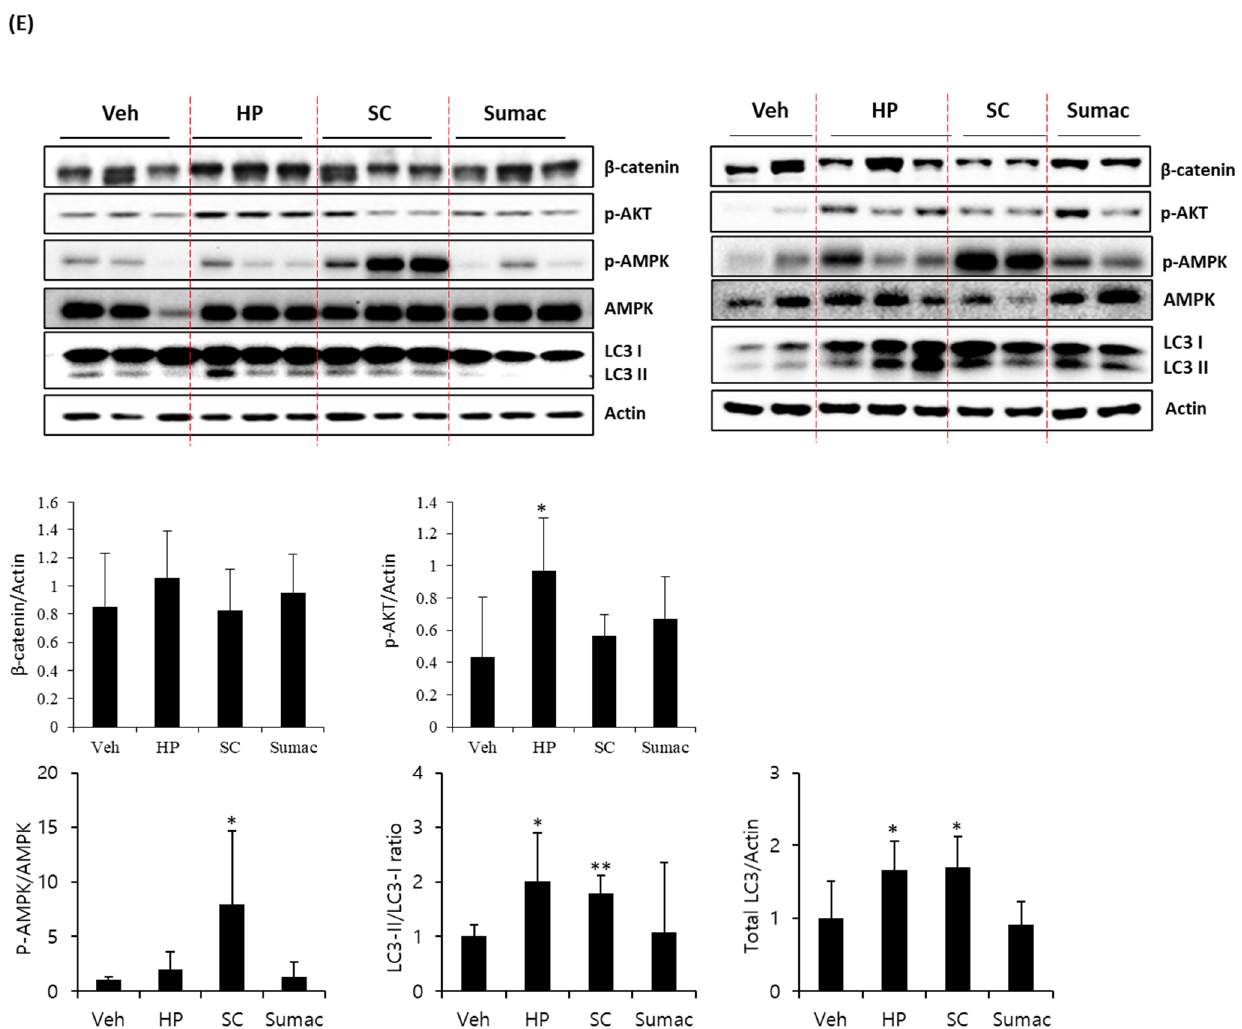
Figure 6. High phenolic sorghum brans repress the formation of colon tumors in APC Min/+ mice. Total 53 APC Min/+ mice were randomly assigned into one of five groups and fed either a control diet ( n = 11) or diets containing low HP (7.5% w/w ; n = 11), high HP (15% w/w ; n = 11), SC (15%; n = 10) and Sumac (15%; n = 10) for 6 weeks. All groups were administered 2% DSS provided through drinking water. ( A ) Experimental design. ( B ) Initial and final body weight of experimental animals. ( C ) The tumor load is calculated based on the number and the size of tumors in colon and rectum. ( D ) Representative image of tumors. ( E ) Expression of indicated genes from colon tumor tissues obtained from vehicle ( n = 5), 15% HP ( n = 6), 15% SC ( n = 5) and 15% Sumac ( n = 5)-treated mice. Bar graphs indicate the average per group. Significant differences between the vehicle- and sorghum bran-treated groups are indicated as * p < 0.05, ** p < 0.01.